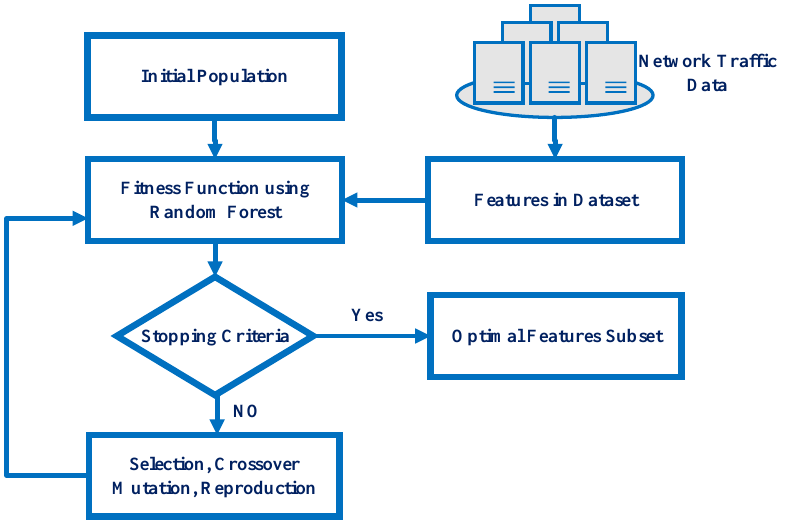
Figure 2. Genetic algorithm